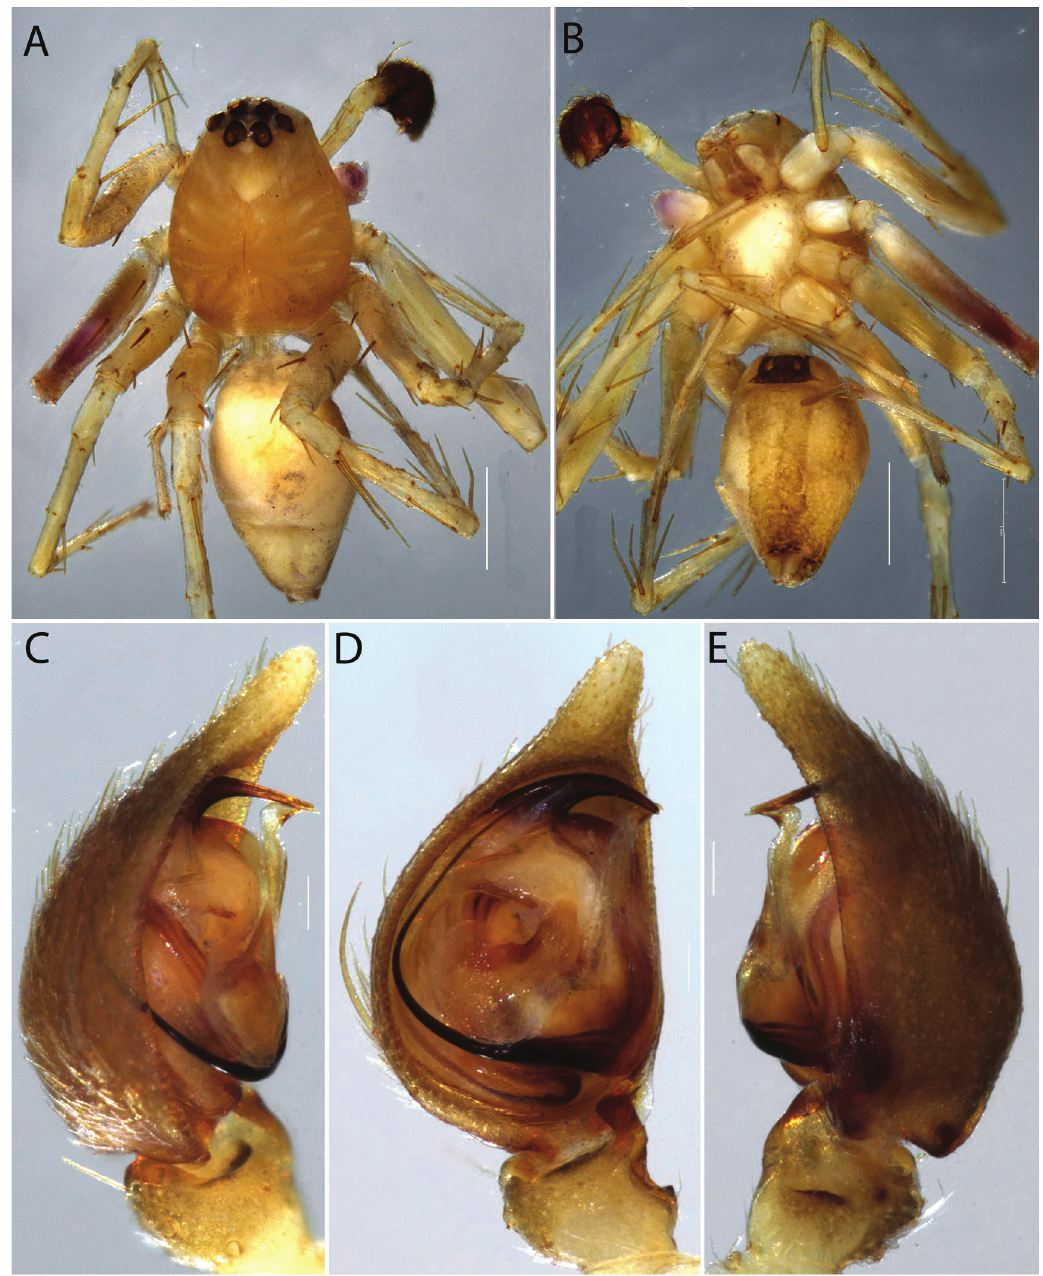
Figure 8. Oxyopes gracilipes (White, 1849) , male syntype ( ZMH- A0000007): A , habitus, dorsal view; B , habitus, ventral view; C, male palp, prolateral view; D, same, ventral view; E , same, retrolateral view. Scale bars: habitus 1.0 mm, palp 0.1 mm.